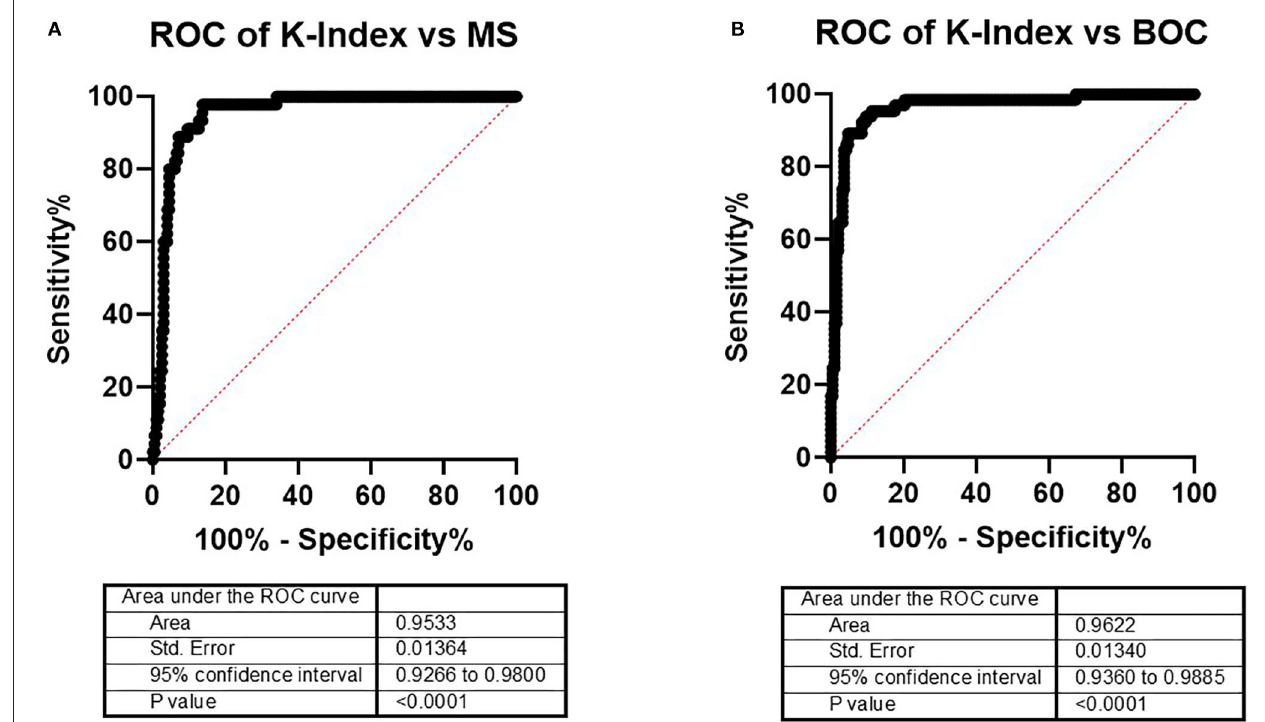
FIGURE 3 | ROC curves for the K-Index performance to discriminate (A) MS patients from non-MS patients and (B) patients positive from patients negative for OCB. ROC, receiver operating characteristic; K-Index, kappa index; MS, multiple sclerosis; OCB, oligoclonal band.